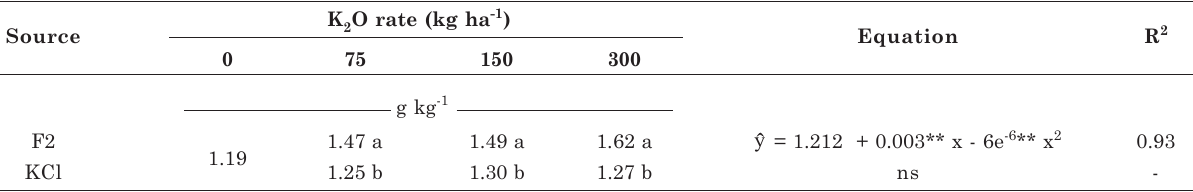
Values followed by the same letter in the column, within the rates of 75, 150, and 300 kg ha -1 K at 5 % according to the LSD test. ns: not significant; ** significant at 1 % by the t